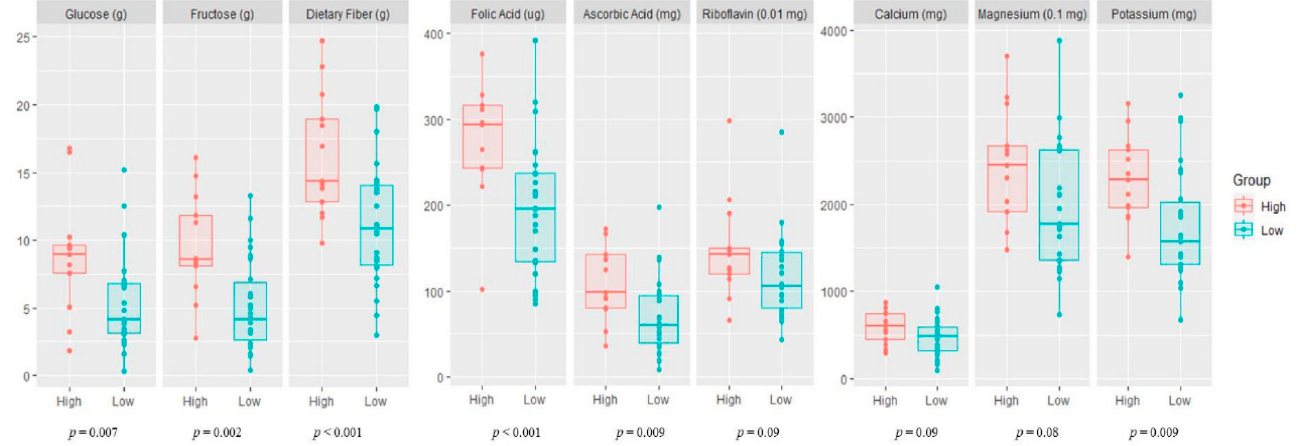
Figure 1. Maternal nutrient intake during pregnancy according to vegetable and fruit consumption. High, high maternal consumption of fruits and vegetables during pregnancy; Low, low maternal consumption of fruits and vegetables during pregnancy.